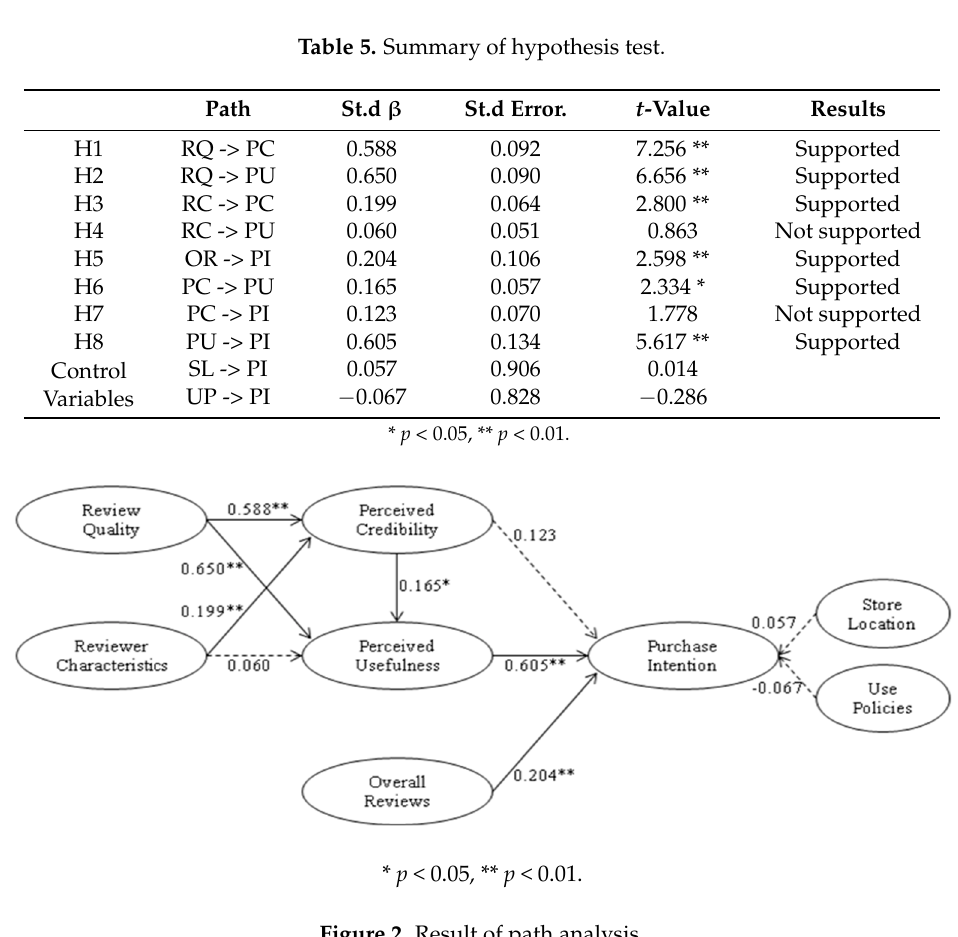
Figure 2. Result of path analysis.